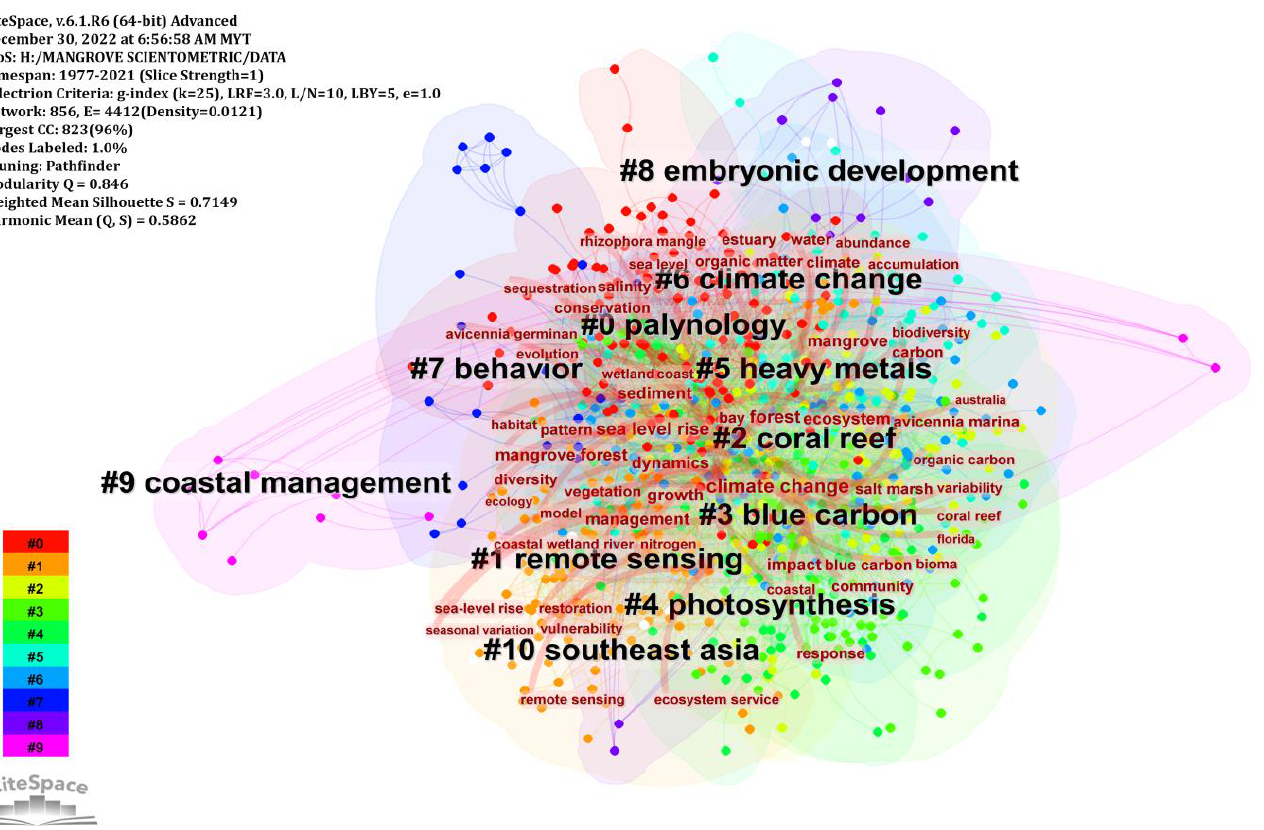
Figure 9. Keyword clustering analysis for mangrove and climate change publications (1977 – 2021).